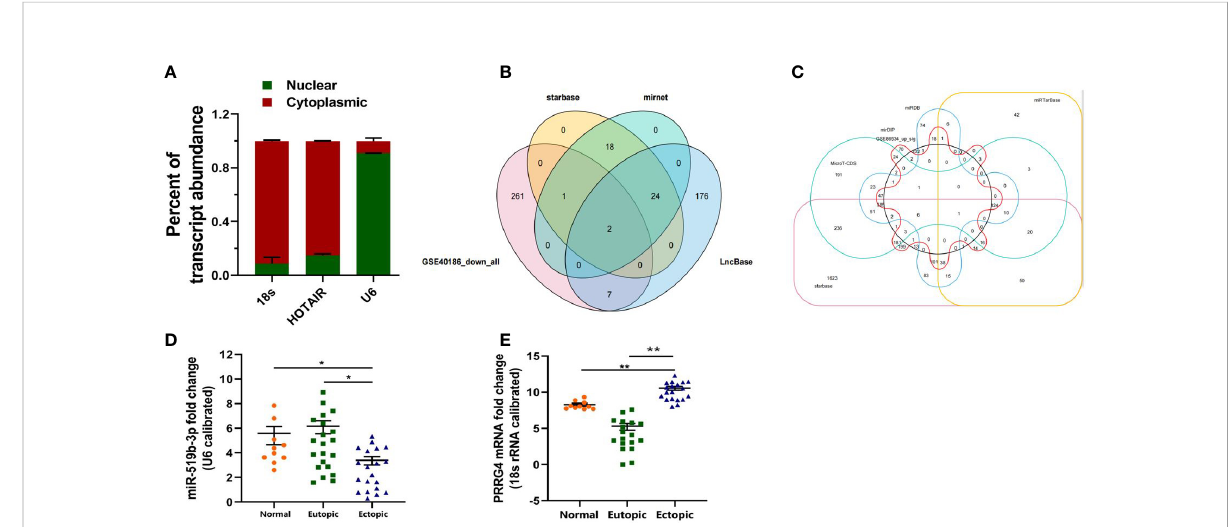
FIGURE 2 Downstream target genes of LncRNA HOTAIR were predicted by bioinformatics analysis and examined by qRT-PCR. (A) Nucleus – cytoplasm separation assay was used to determine the subcellular distribution of LncRNA HOTAIR in endometrial stromal cells. (B) Prediction of the downstream miRNAs of LncRNA HOTAIR. (C) Prediction of the downstream mRNAs of miR-519b-3p. (D, E) Relative expression level of miR- 519b-3p and PRRG4 was examined in ectopic endometrial tissues compared with that in eutopic endometrial tissues. 18s RNA was used as endogenous control. Normal, normal endometrial tissues of patients without endometriosis; Eutopic, eutopic endometrial tissues of patients with endometriosis; Ectopic, ectopic endometrial tissues of patients with endometriosis. Data are presented as the mean ± SEM. *P<0.05, **P<0.01 vs.